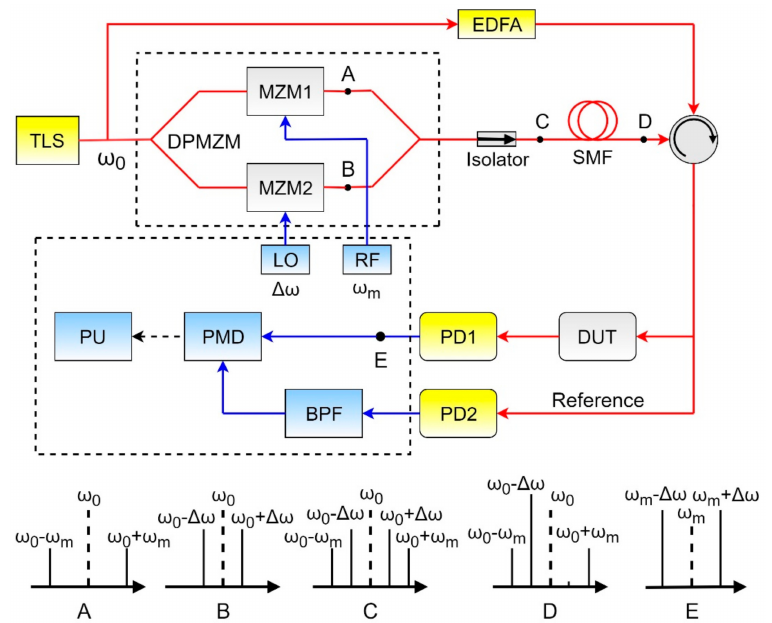
Figure 10. The schematic diagram of the OVA based on asymmetric ODSB and SBS: TLS—tunable laser source; MZM—Mach–Zehnder modulator; DPMZM—dual-parallel MZM; RF—radio frequency; LO—local oscillator; EDFA—erbium doped fiber amplifier;